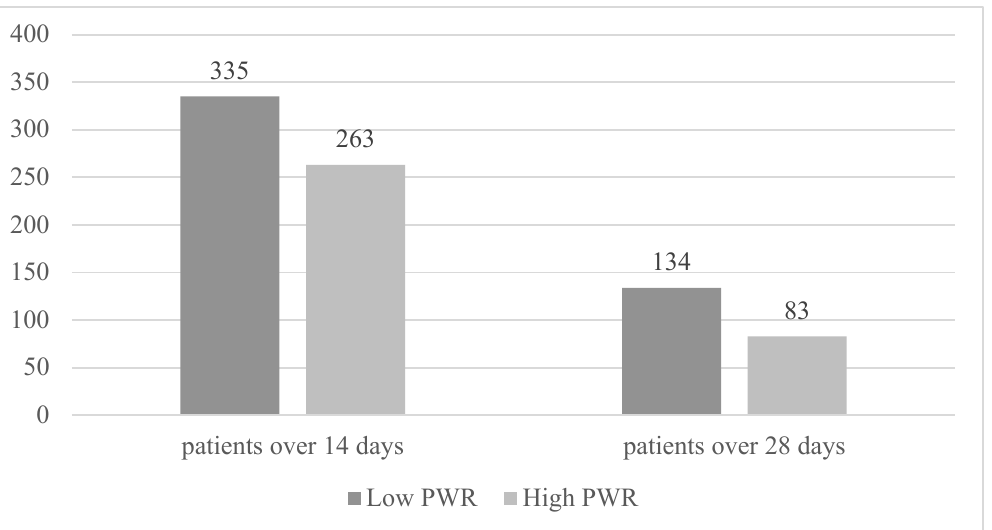
Figure 2. Patient stratification by hospital days. Stratification at hospital days 14 and 28 revealed that the low PWR group required prolonged hospitalization.